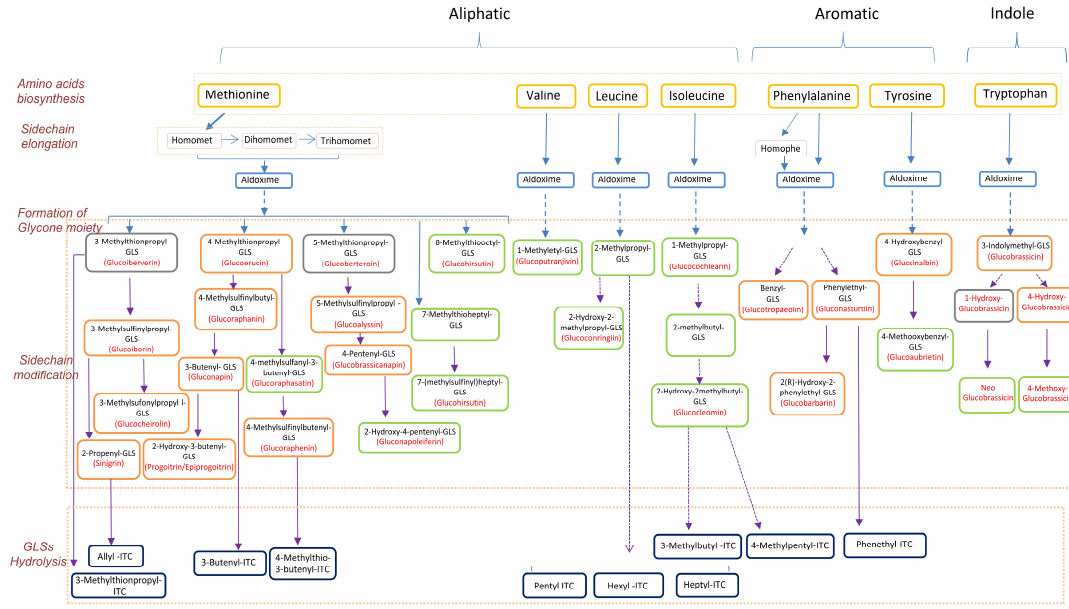
Figure 3. Chart of pathways involving the relevant amino acids, glucosinolates, and isothiocyanates in the 12 vegetables studied. The solid arrow represents the direct step from the upstream metabolites to downstream metabolites, and the dashed arrow represents multiple steps from the upstream to downstream metabolites. Glucosinolates in orange box are quantified with pure standards, glucosinolates in green box are identified by comparison with MS/MS features in the database METLIN (http://metlin.scripps.edu/), and glucosinolates in grey box are not detected in this study. GLS: glucosinolate, ITC: isothiocyanate.